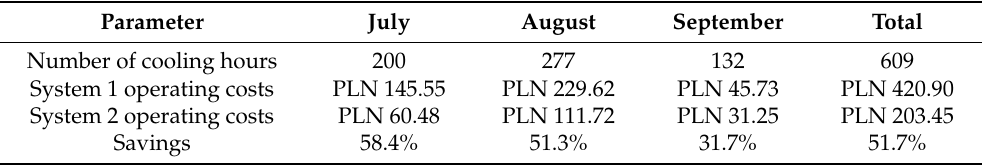
Table 7. Monthly operating costs for each